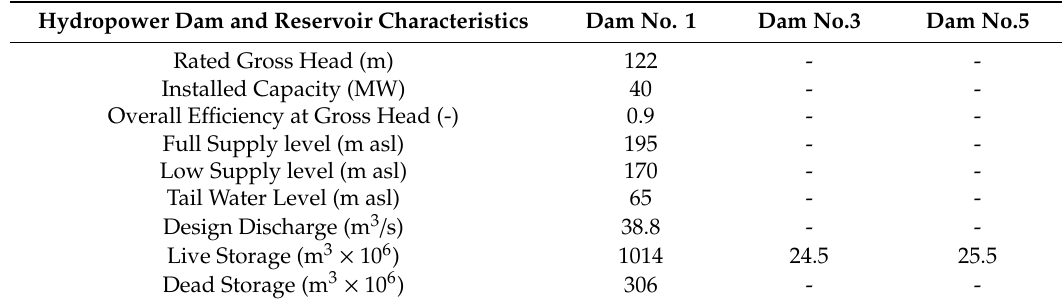
Table 1. The characteristics of the Hydropower Dam No.1, Reservoir Dam No.3 and Reservoir Dam No.5. Hydropower Dam and Reservoir Characteristics